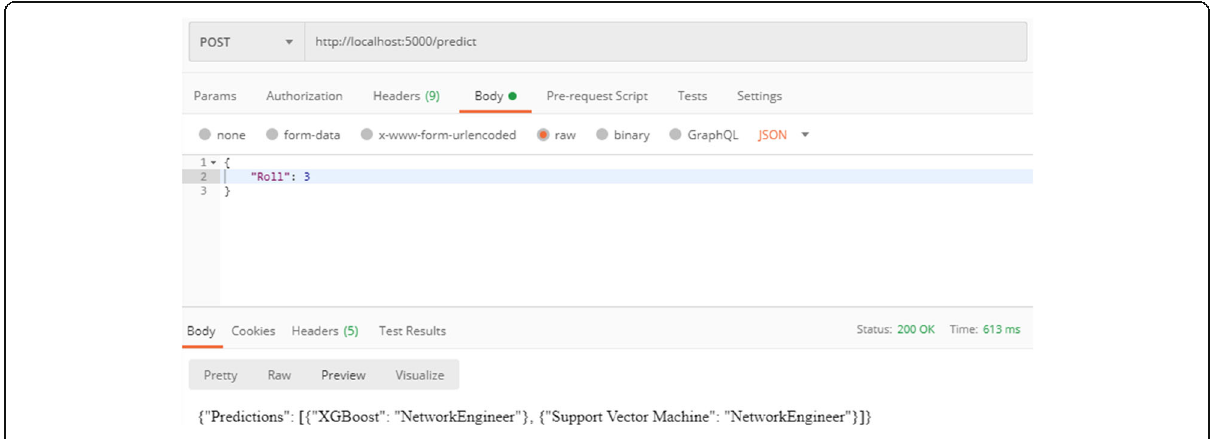
Fig. 11 A ‘ POST ’ request made to the ‘ predict ’ router of the Flask server with the help of Postman